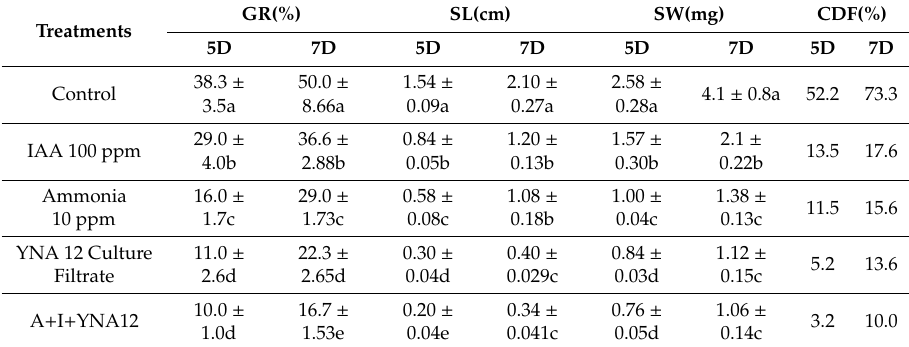
Table 1. Adverse e ff ect of di ff erent treatments on the germination of evening primrose seeds. GR(%) Treatments